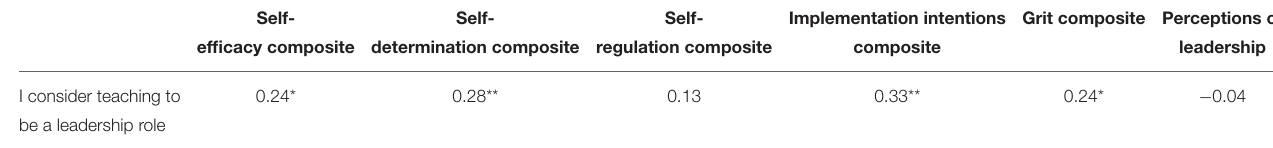
TABLE 5 | Correlations Among Attributes, Perceptions of Leadership, and Consideration of Teacher as a Leadership Role.